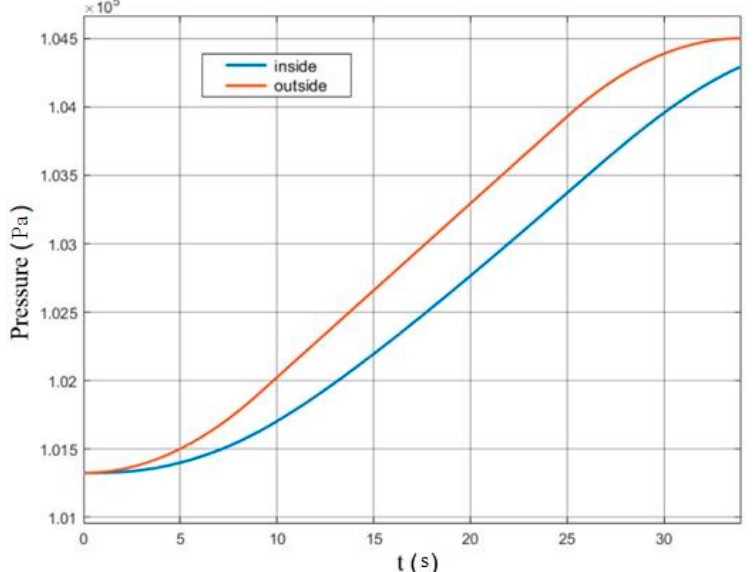
Figure 16. Air pressure change value curves inside and outside the car under continuous ventilation.